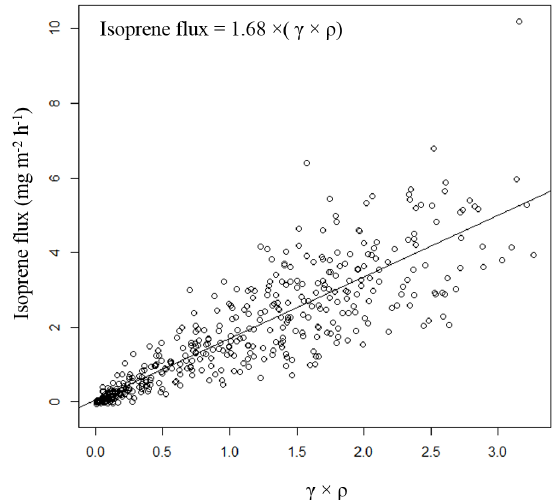
Figure 9. Measured isoprene fluxes against the product of γ (emis- sion activity factor, itself the product of the temperature, light and leaf area index activity factors) and ρ (the canopy loss and produc- tion factor).